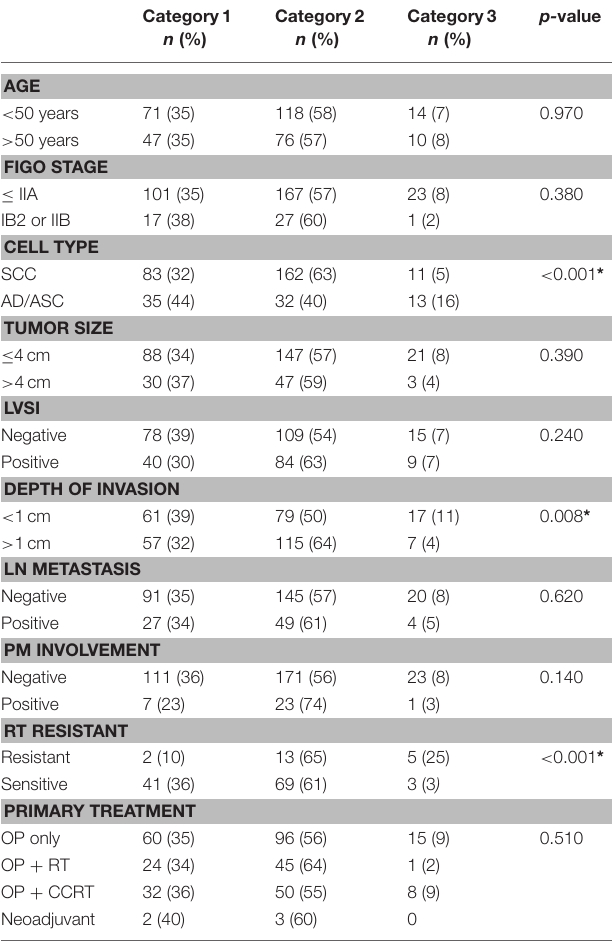
FIGO, International Federation of Gynecology and Obstetrics; SCC, squamous cell carcinoma; AC, adenocarcinoma; ASC, adenosquamous cell carcinoma; LVSI, lymphovascular space invasion; LN, lymph node; PM, parametrium; OP, operation; RT, radiotherapy; CCRT, concurrent chemoradiation. * Significant at the level of p < 0.05. multivariate analysis (HR13.2; 95% CI, 3.72–46.89; p < 0.001 and HR43.07; 95% CI, 3.72–499.18; p = 0.003, respectively; Table S2